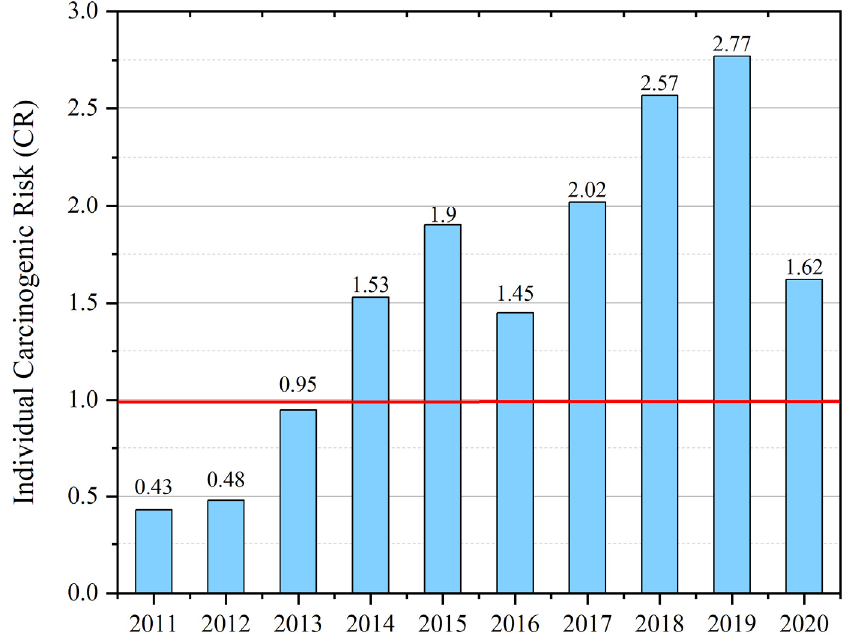
Figure 3. The level of individual carcinogenic risk to public health from exposure to pollutants in the atmospheric air of Ulan-Ude, 2011–2020 (CR × 10 − 4 ). Permissible level CR = 1 × 10 − 4 . Table 5. Comparative characteristics of morbidity in Ulan-Ude and Buryatia for Statistics for the period 2011–2020 show that for some risk-related diseases, the mor- bidity of the population in Ulan-Ude exceeds the average figures for the Republic of Bury- atia. The total morbidity rate in Ulan-Ude was 1.2 times higher than the average in Bury- atia and amounted to 77,077.63 cases per 100 thousand people (63,985.43 cases per 100 thousand people in Buryatia). Respiratory system morbidity in Ulan-Ude was 34,154.29